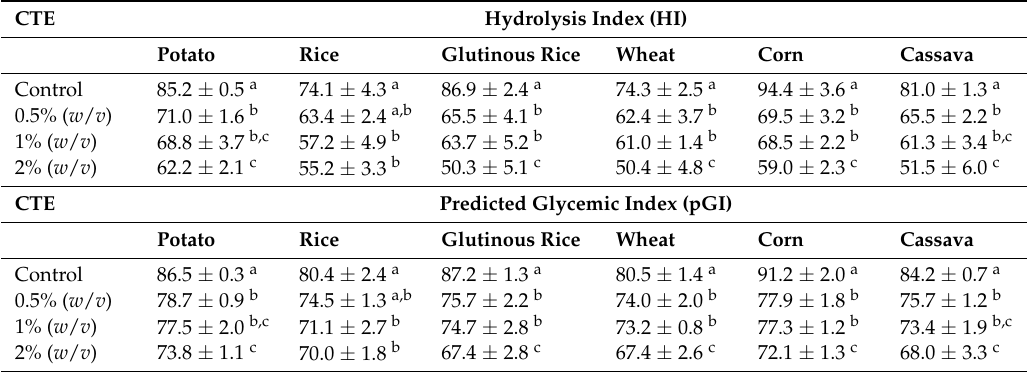
Table 2. The hydrolysis index (HI) and predicted glycemic index (pGI) of the flours with CTE.